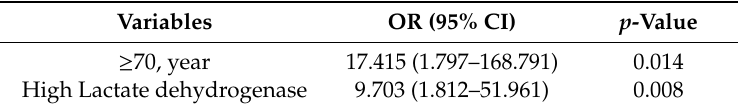
Table 4. Multivariate regression analysis results for risk factors of mortality in COVID-19 patients with